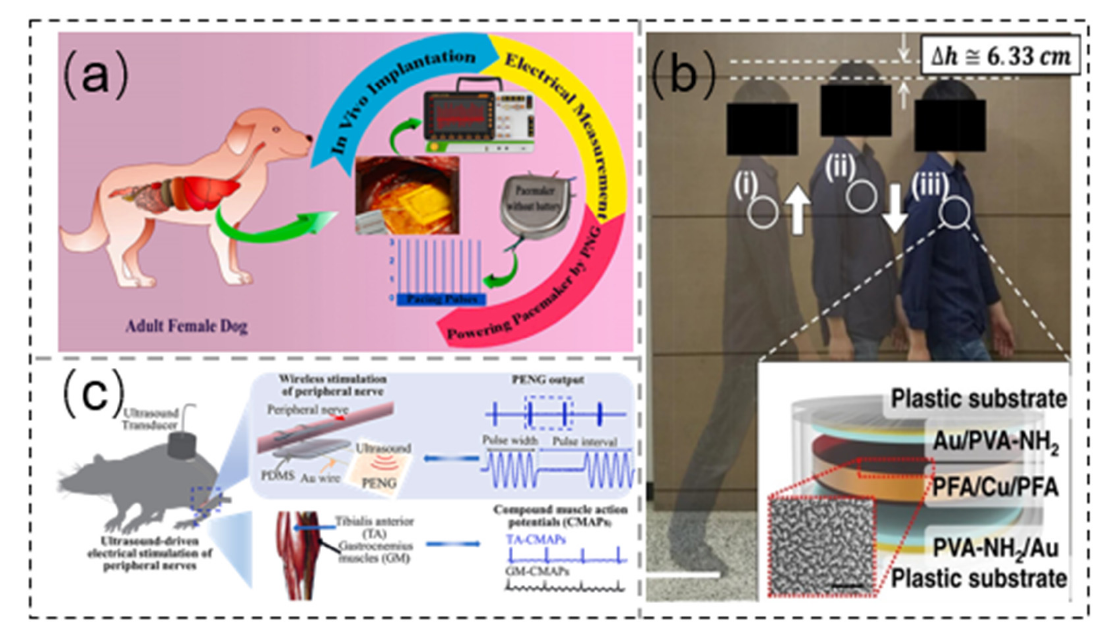
Figure 13. Implantable device applications. ( a ) Photograph of PNG attached to the LV wall. Reprinted with permission from Ref. [157]. Copyright 2021 Elsevier. ( b ) Photograph of a walker, along with schematic image of the I-TENG. Reprinted from Ref. [158]. ( c ) Photograph of nanogenerator implanted with a soft piezoelectric film to electrically stimulate peripheral nerves in rat. Reprinted with permission from Ref. [159]. Copyright 2021 Elsevier.